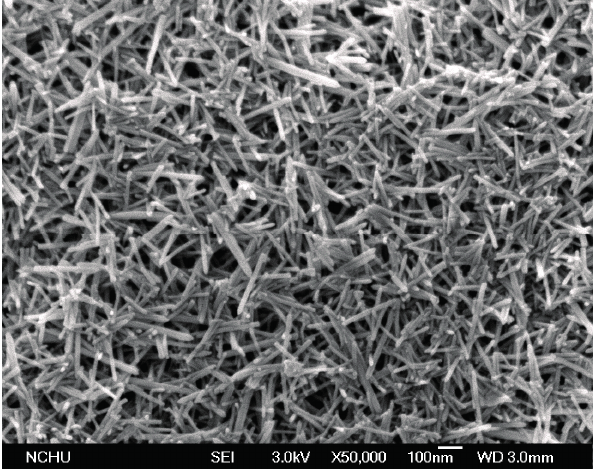
Figure 4. SEM image of the zinc oxide film.